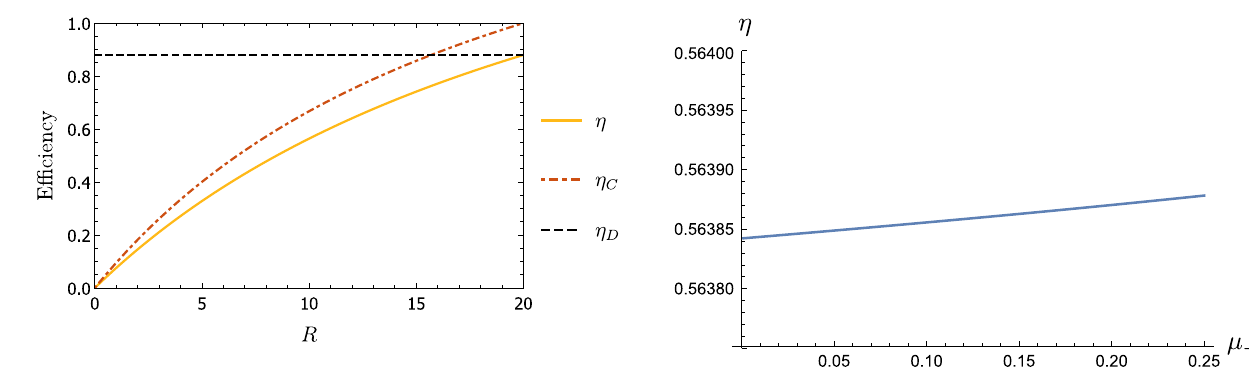
cant since the difference shows up only in the 5th significant